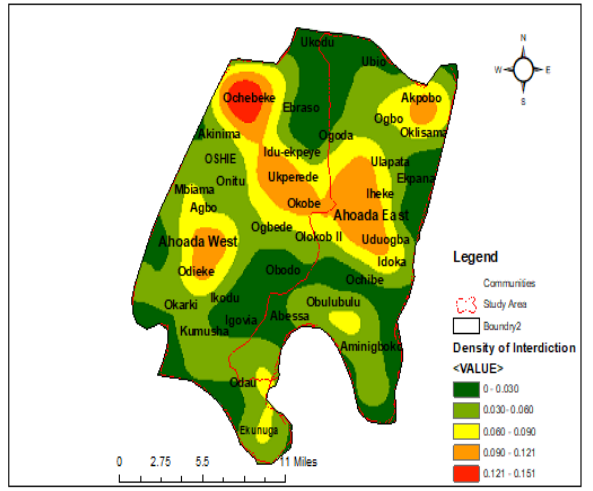
Figure 5. Oil spill hotspot map by interdictions using KDE